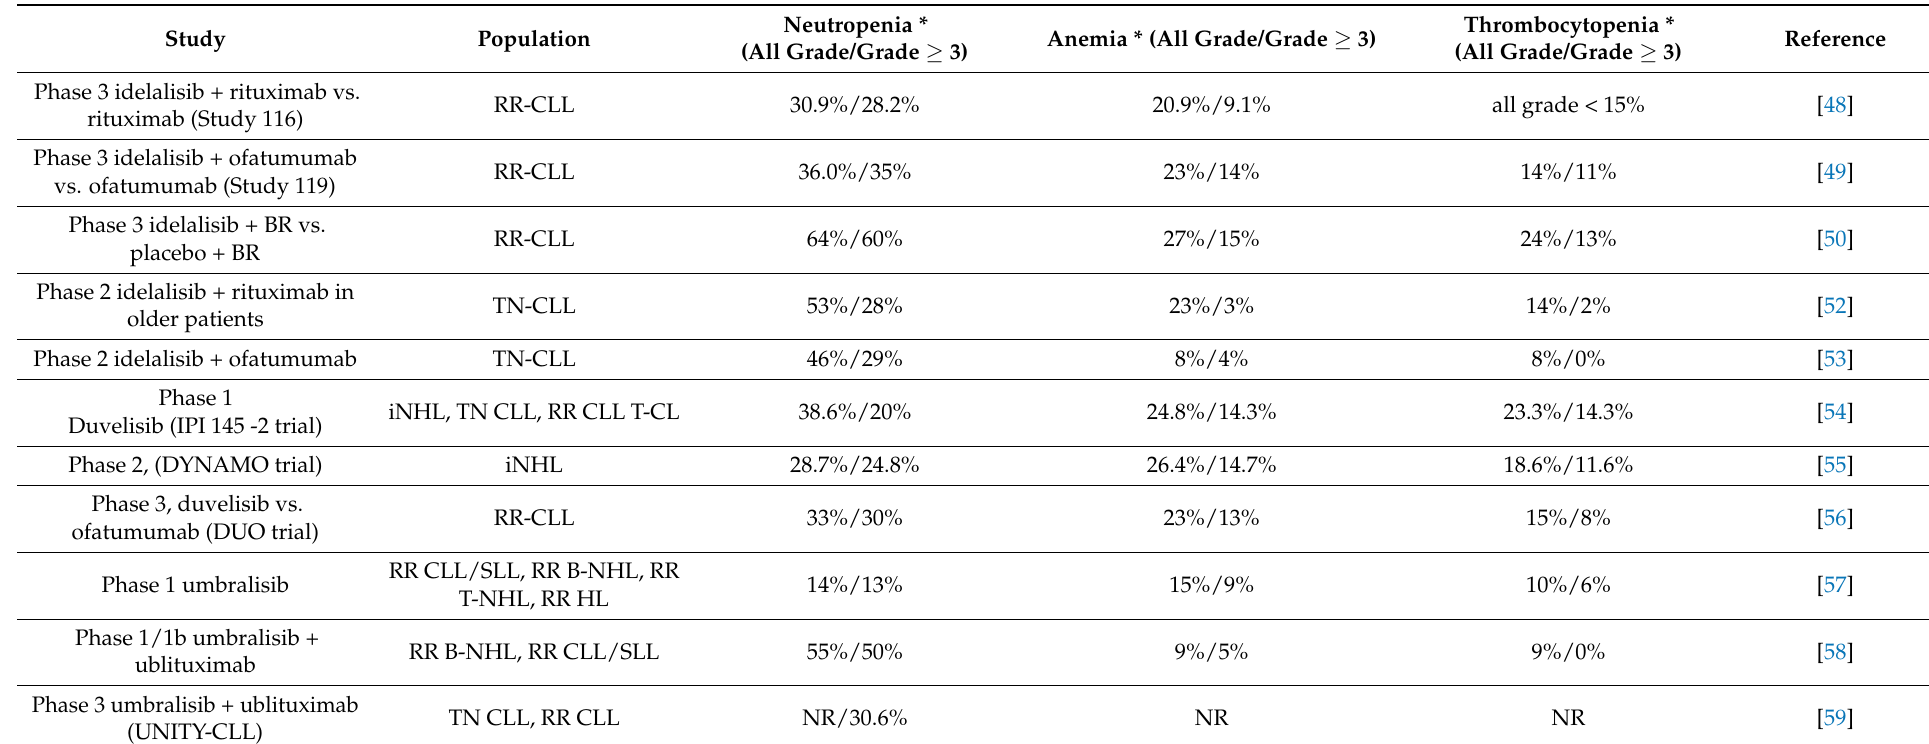
Table 4. Summary of hematological PI3K related adverse events across selected